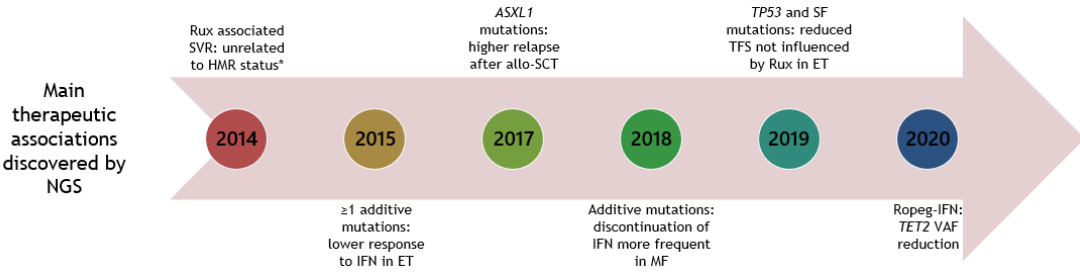
Figure 2. Timeline of NGS studies in patients with MPNs, unravelling main therapeutic associations.